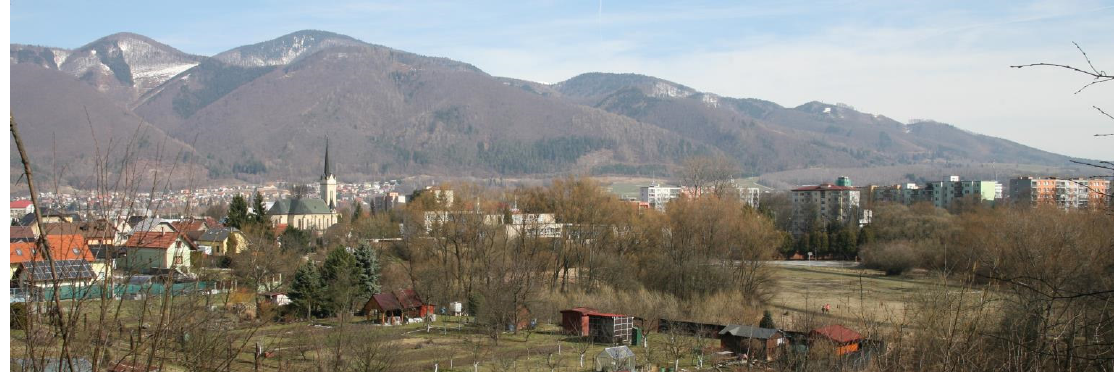
Figure 2. The Malá Fatra mountains embody an important barrier for transportation networks. A Figure 2. The Mal á Fatra mountains embody an important barrier for transportation networks. A view view over the individual and collective housing in the town of Vrútky (Photo: J. Nozdrovická, 2018). over the individual and collective housing in the town of Vr ú tky (Photo: J. Nozdrovick á ,